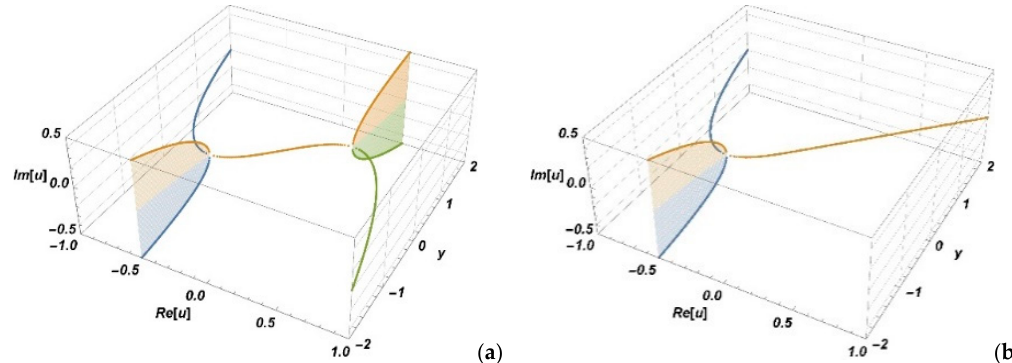
( 1 ) ( − 1, y ; u ) are shown in 1